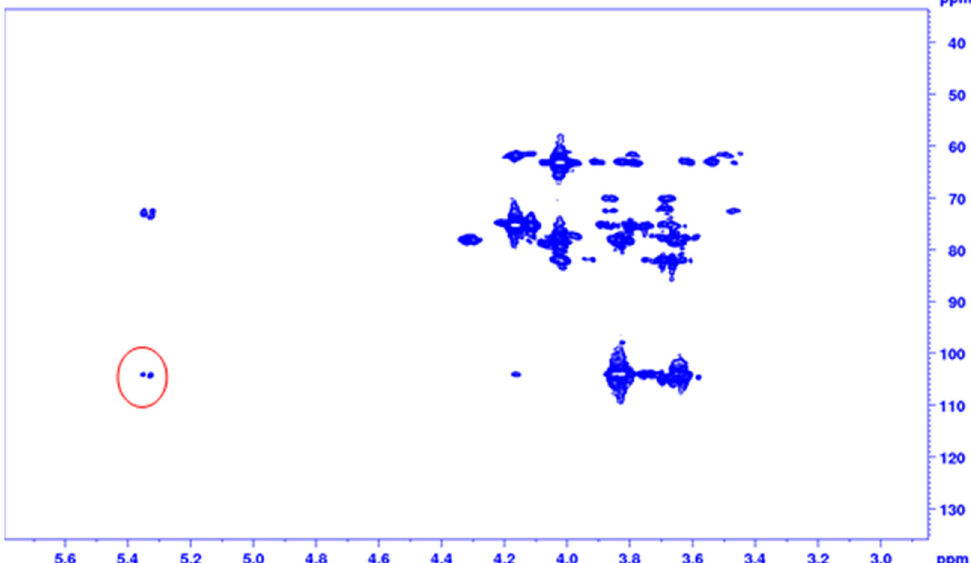
Figure 3. 1 H- 13 C 2D heteronuclear multiple bond correlation (HMBC) spectrum of AR2, correlation between the H-1 of the glucosyl residue and C-2 fructosyl residue is highlighted.